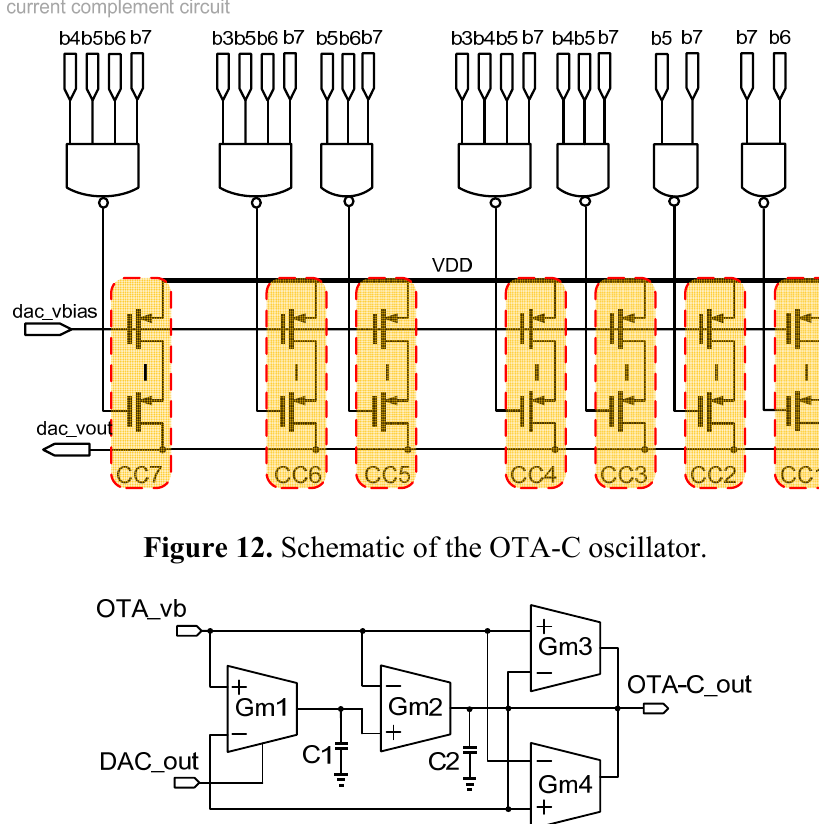
Figure 11. Schematic of the current complementary circuit.